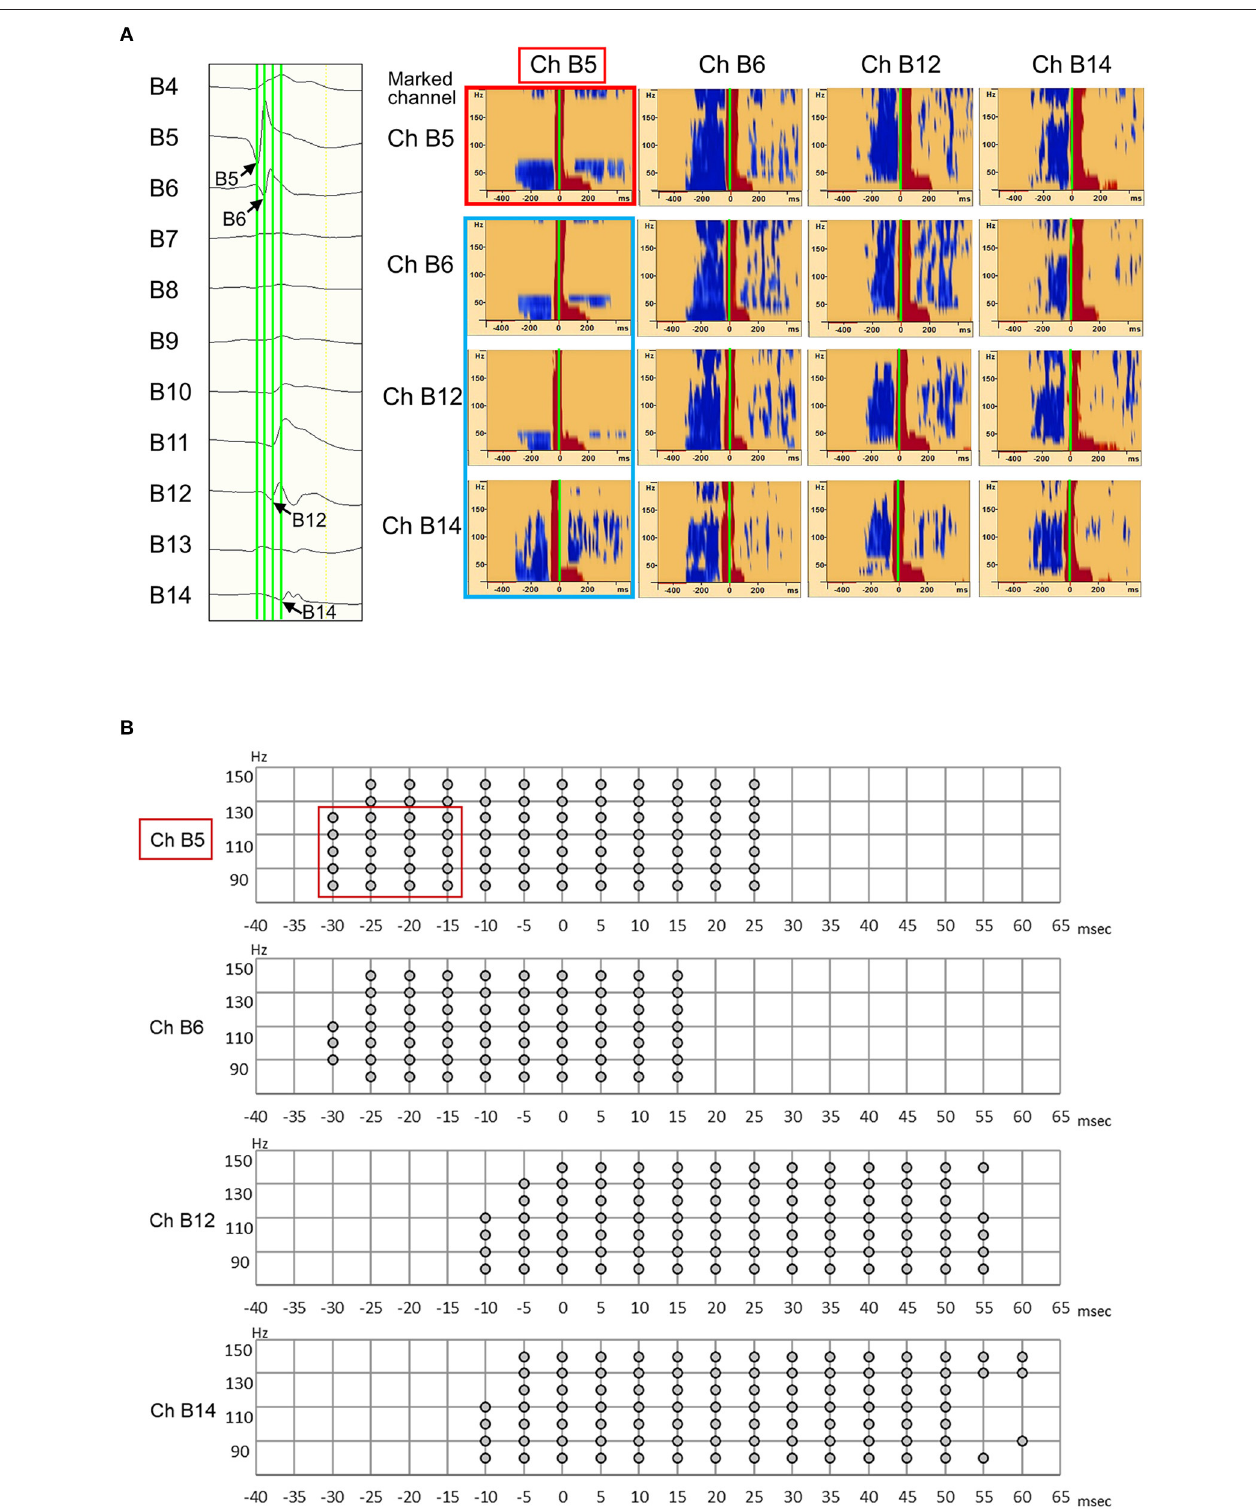
FIGURE 2 | Illustration showing high-frequency oscillation (HFO) onset in Ch B5 for all marked channels (B5, B6, B12, and B14). ( A , left) Interictal electrocorticography (ECoG) traces are shown, along with interictal spike propagation. In the enlarged ECoG trace, marks (green line) are attached to the rising edge of the Ch B5, Ch